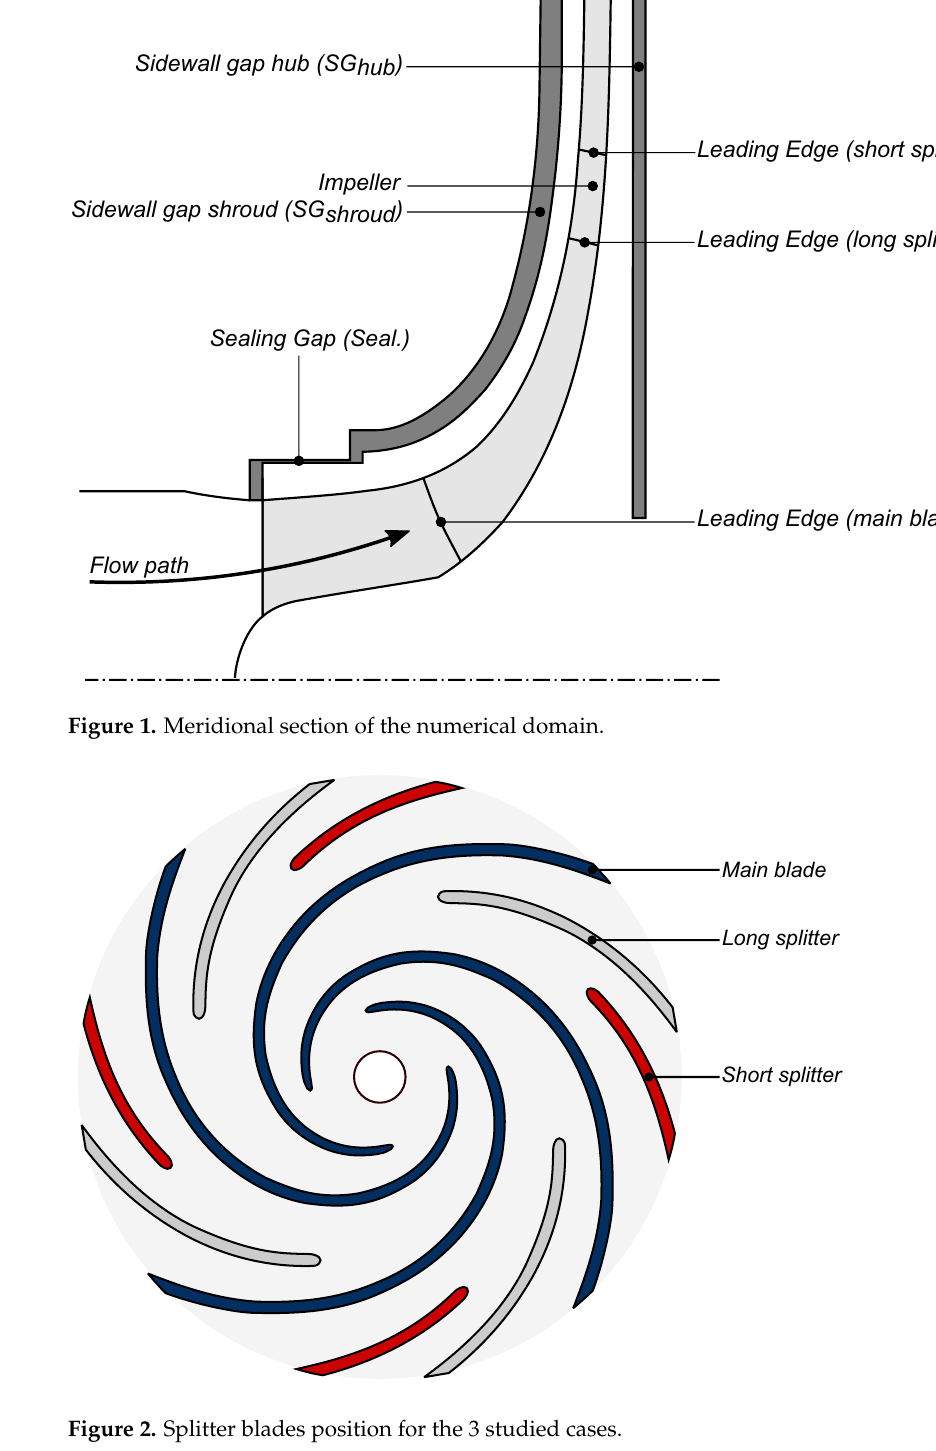
Figure 2. Splitter blades position for the 3 studied